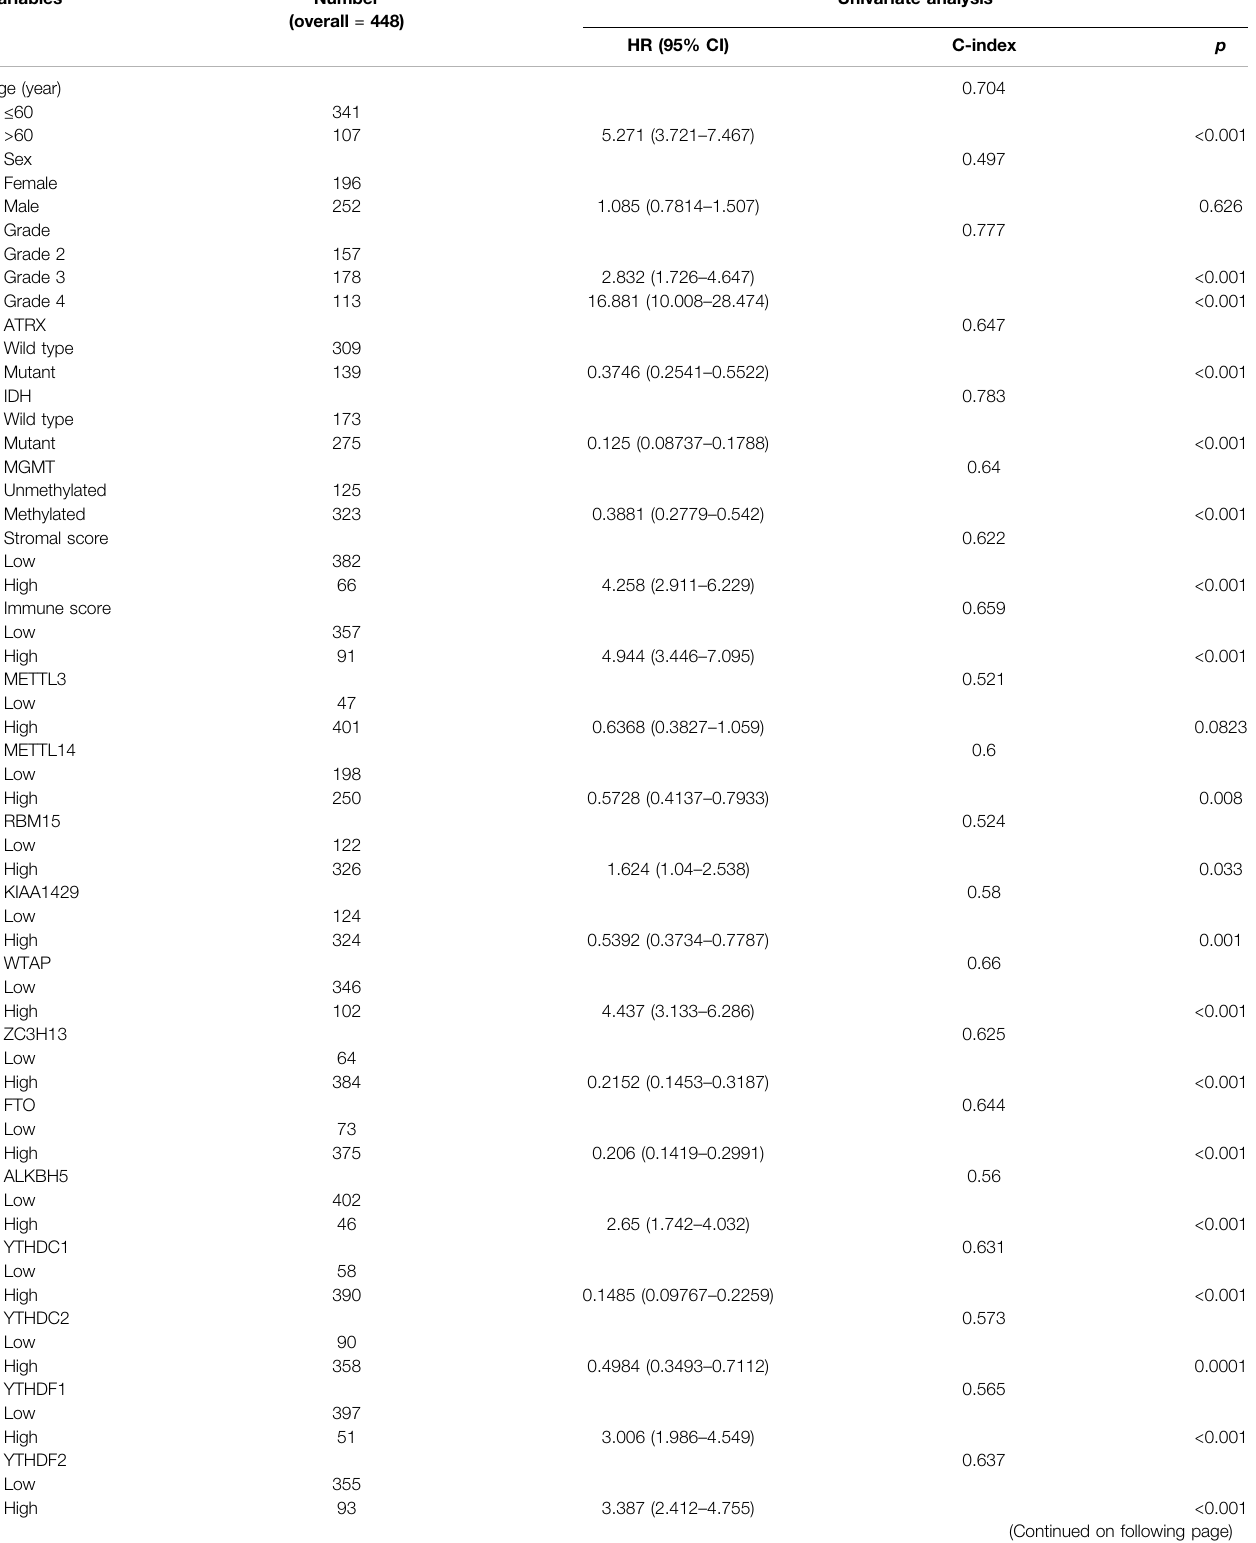
TABLE 1 | Univariate analysis of overall survival using the Cox proportional-hazards regression